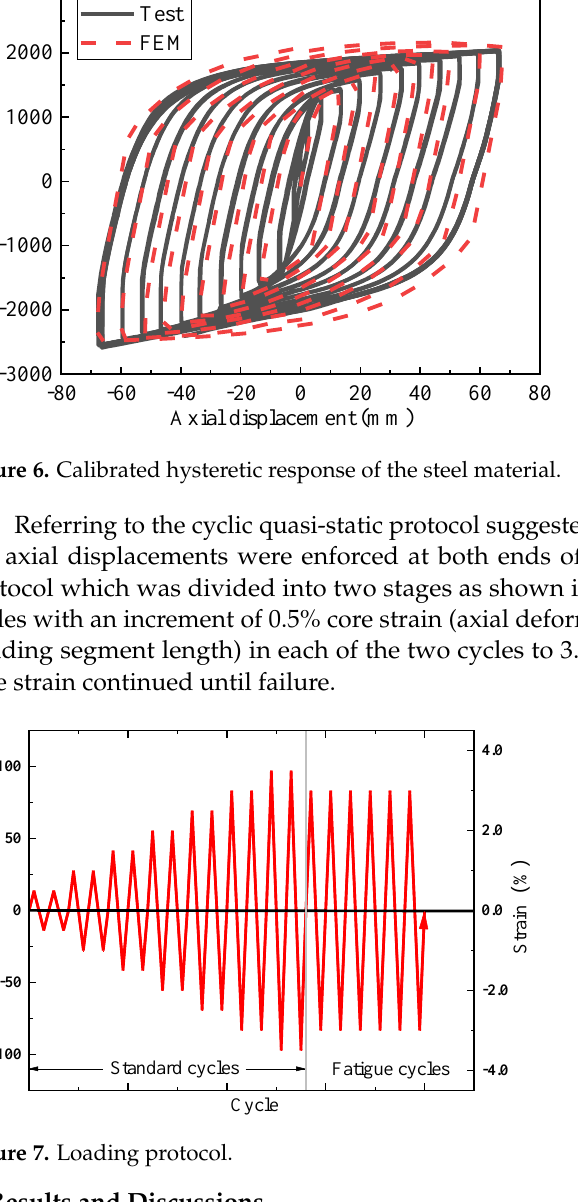
Figure 7. Loading protocol .